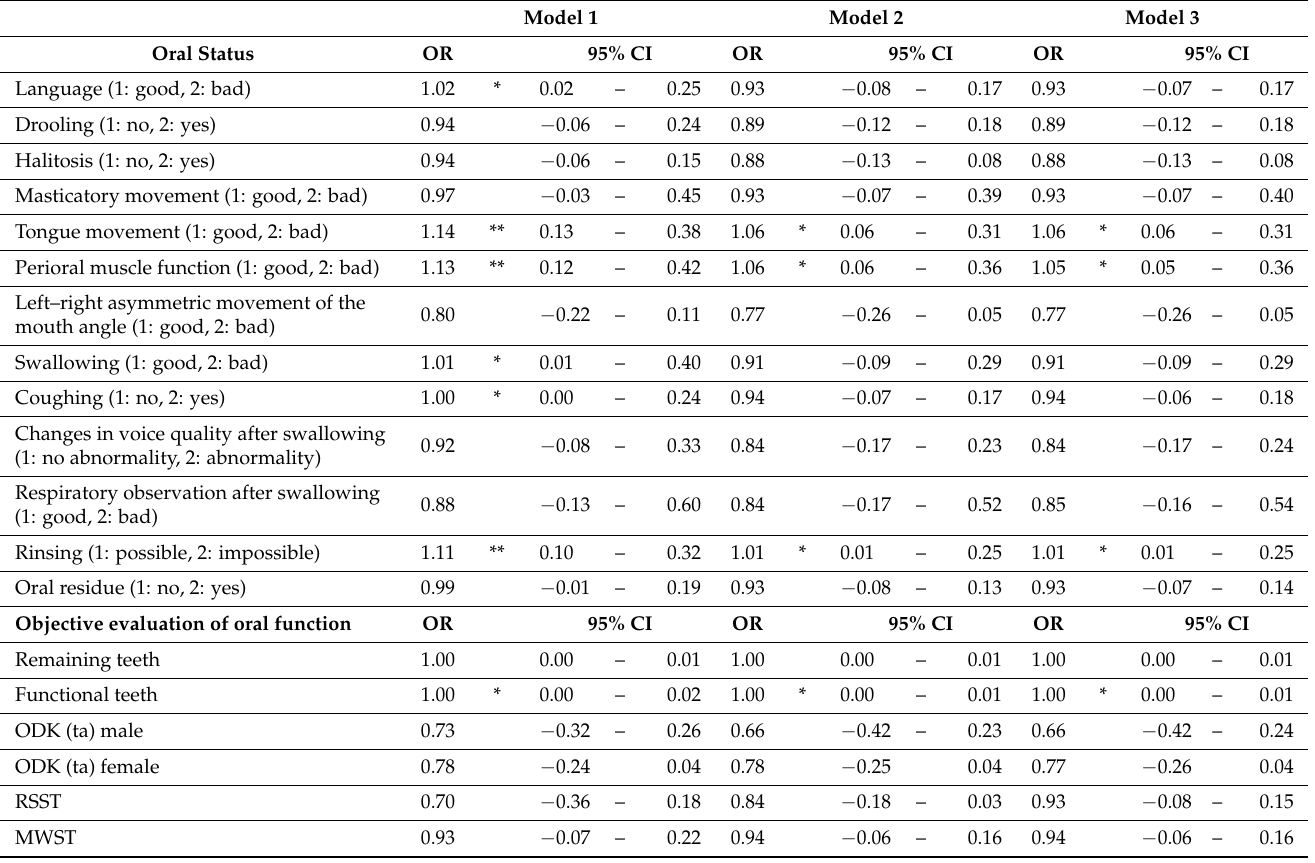
Table 3. Results of the multi-level analysis of simple evaluation (oral conditions) and objective evaluation of the oral function. Model 1 Model 2